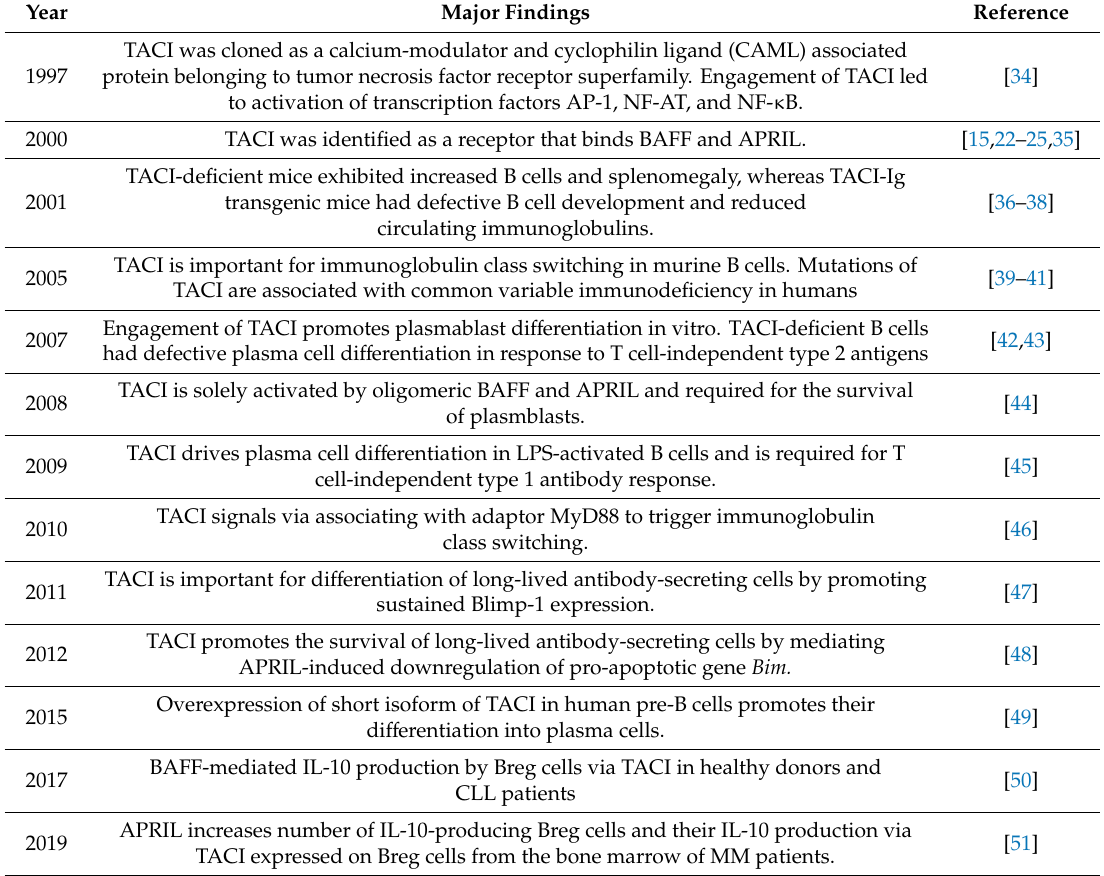
Table 1. Studies for the role of TACI in B cell function and di ff erentiation. Major Findings